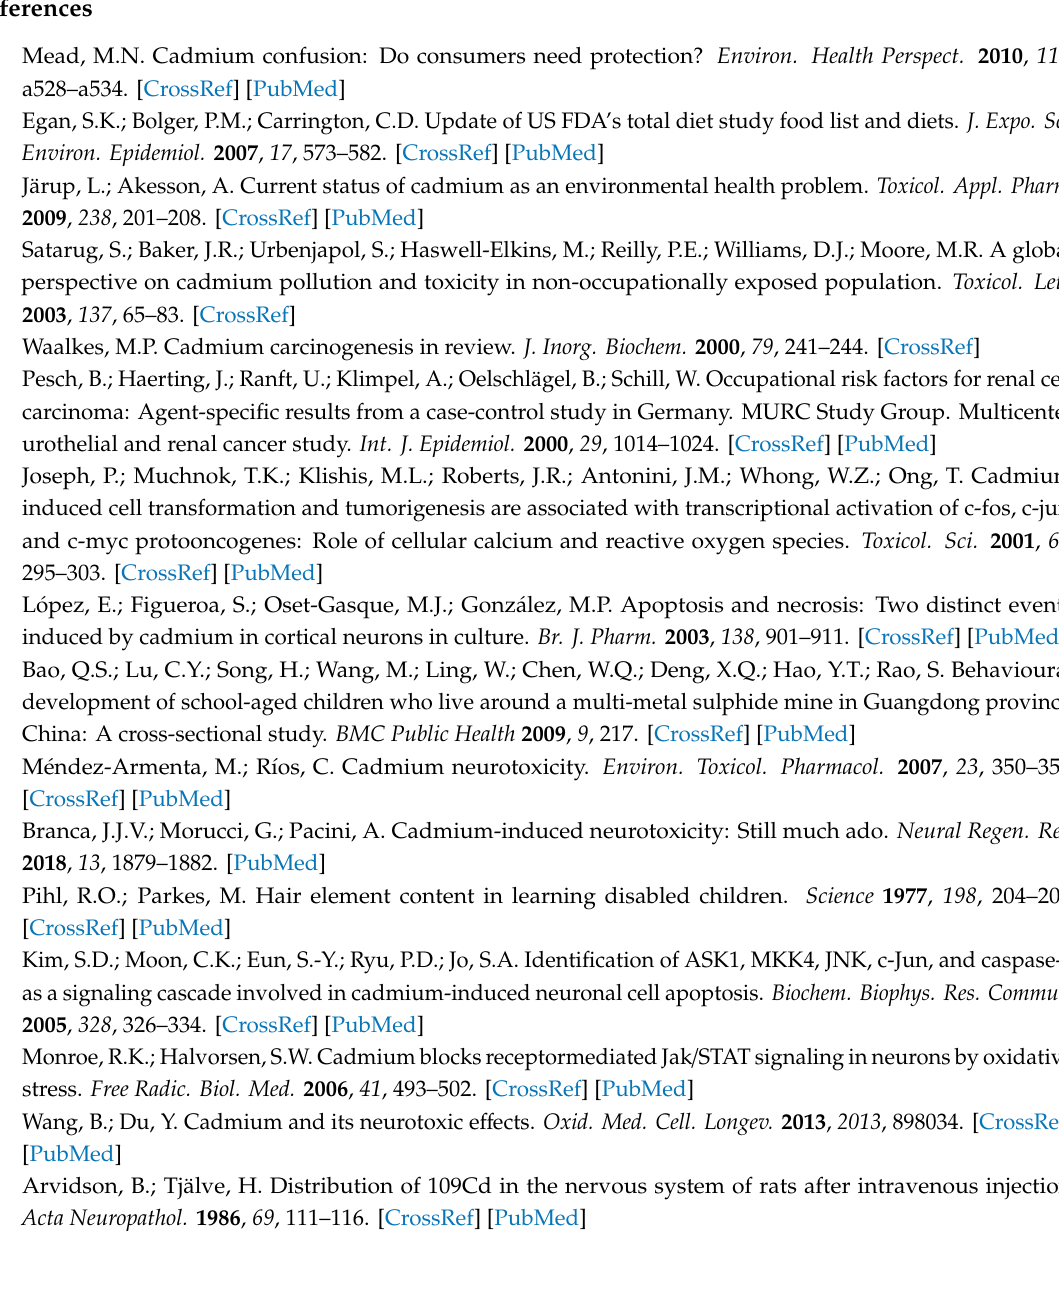
Supplementary Materials: The following are available online at http: // www.mdpi.com / 1660-4601 / 16 / 22 / 4420 / s1, Figure S1: Immunofluorescence staining of ROS positive